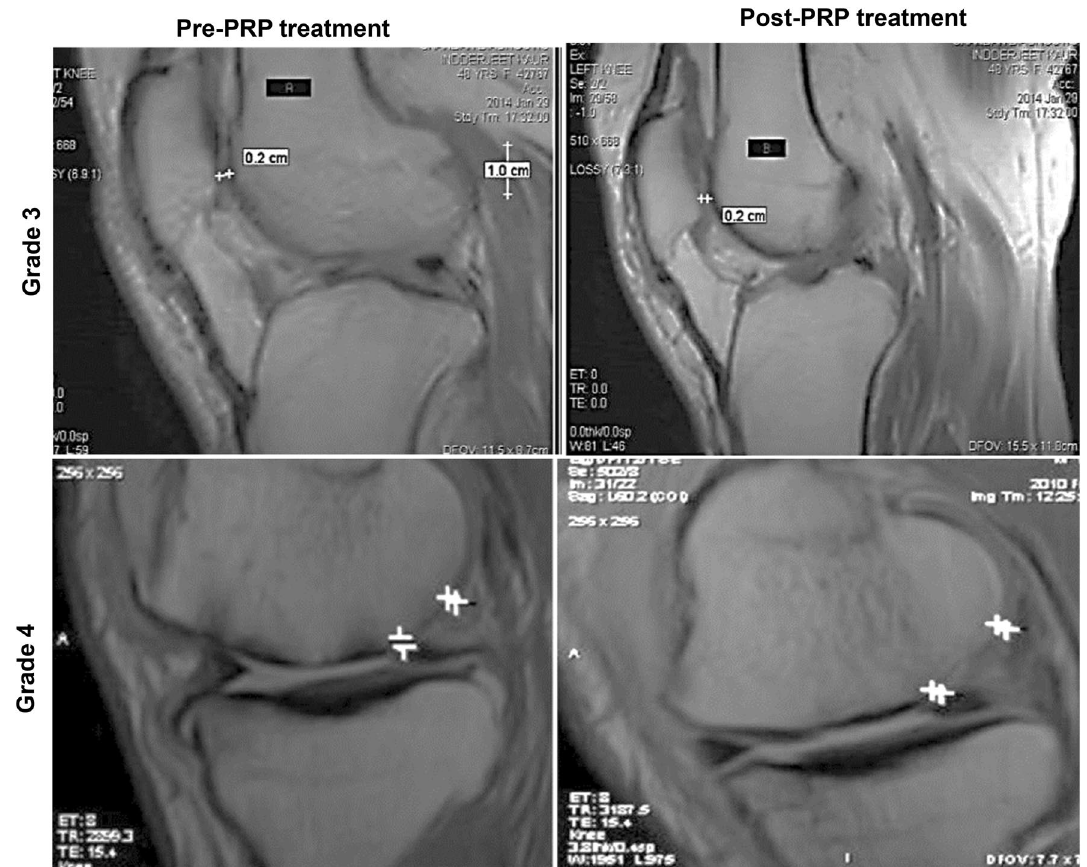
Figure 3. Evaluation of articular cartilage thickness using MRI after one year of PRP treatment in patient with grade 2 and grade 3 OA